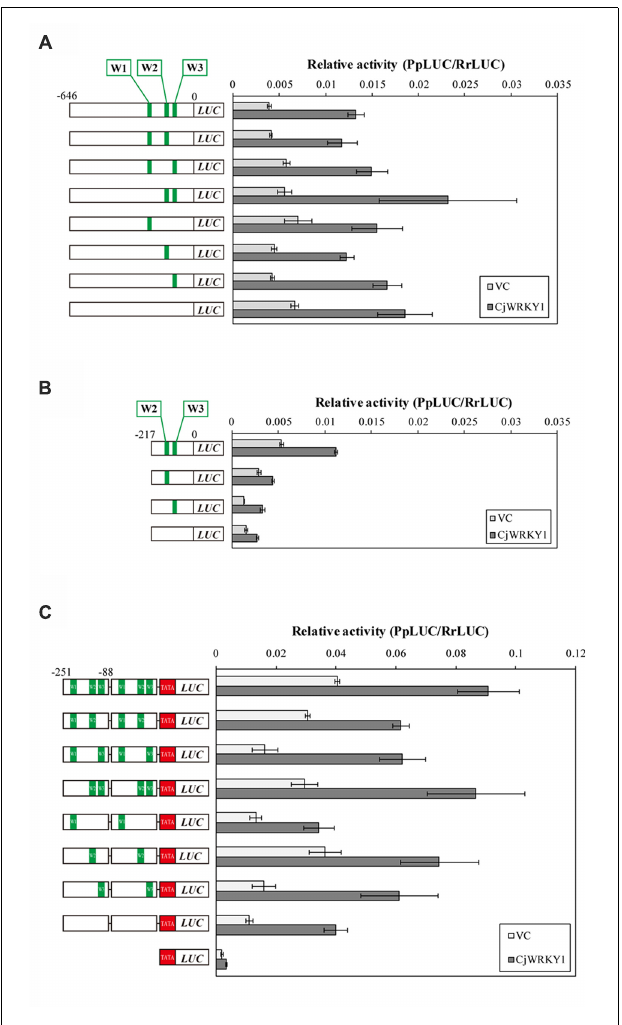
FIGURE 5 | Mutation of W-box elements in the CYP80B2 promoter affected the transcriptional activity of CjWRKY1. Reporter constructs that contain the full length CYP80B2 promoter (A) , the deleted 217 bp CYP80B2 promoter (B) and tandem repeats of the 163 bp CYP80B2 promoter (C) with or without W1, W2, and W3 elements were co-transformed into C. japonica protoplasts with effector plasmids. The relative LUC activities were measured by a dual-LUC reporter assay. The values are the average of three biological transfections and the data are represented as the mean ± SD.